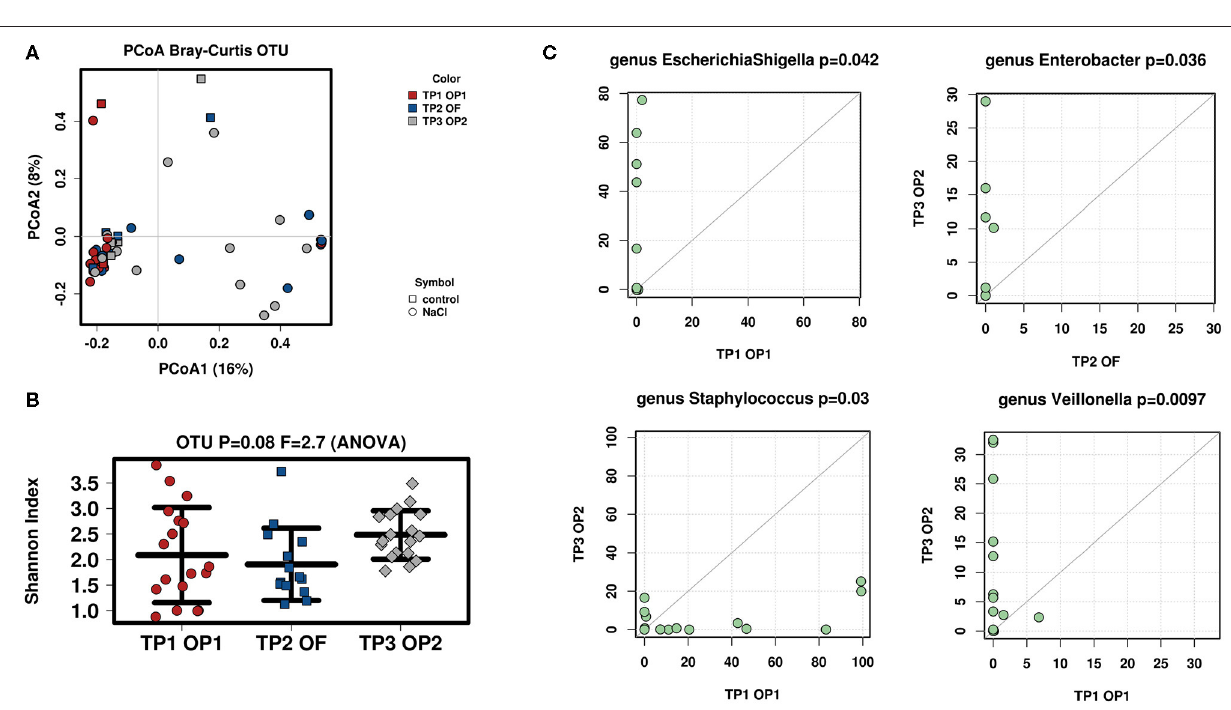
FIGURE 2 | Analysis of microbial diversity and taxa abundance as to changes in time (TP1 OP1, TP2 OF, TP3 OP2). (A) PCoA of all samples was performed to evaluate ß-diversity of observed OTUs: Microbiota composition between all infants became increasingly diverse with time (TP1 OP1–TP3 OP2). (B) Shannon-Index was used to analyze α -diversity at OTU-level (read depth was normalized to 1321): Microbiota composition within infants showed a fluctuating diversity at different points in time (TP1 OP1, TP2 OF, TP3 OP2). Increasing interindividual diversity and fluctuating intraindividual variation may arise from individually distinct influences on the recovering intestine. (C) Total-sum scaling (TSS) was applied to evaluate taxa abundance at genus-level. Significant differences were seen in EscherichiaShigella (TP1 OP1 vs. TP2 OF), Staphylococcus (TP1 OP1 vs. TP3 OP2), Enterobacter (TP2 OF vs. TP3 OP2), and Veillonella (TP1 OP1 vs. TP3 OP2). The successive increase of Enterobacteriaceae may be explained by ongoing contact of the stoma to oxygen (25). A simultaneous decrease in Staphylococcus might be provoked by postoperative recovery of the surgery wound (